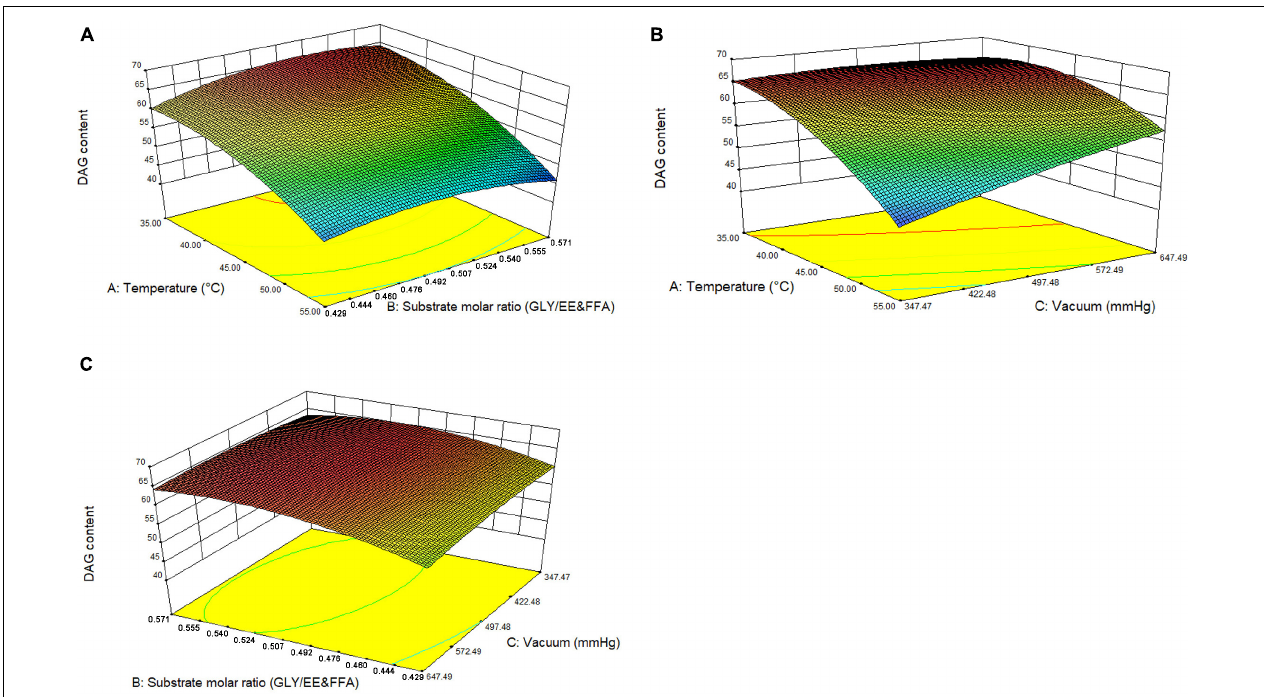
FIGURE 4 | 3D response surface graphs for the pairwise interactive effects on the conversion of EE and FFA to DAG yield. (A) temperature vs. substrate molar ratio, (B) temperature vs. vacuum, (C) substrate molar ratio vs . vacuum.